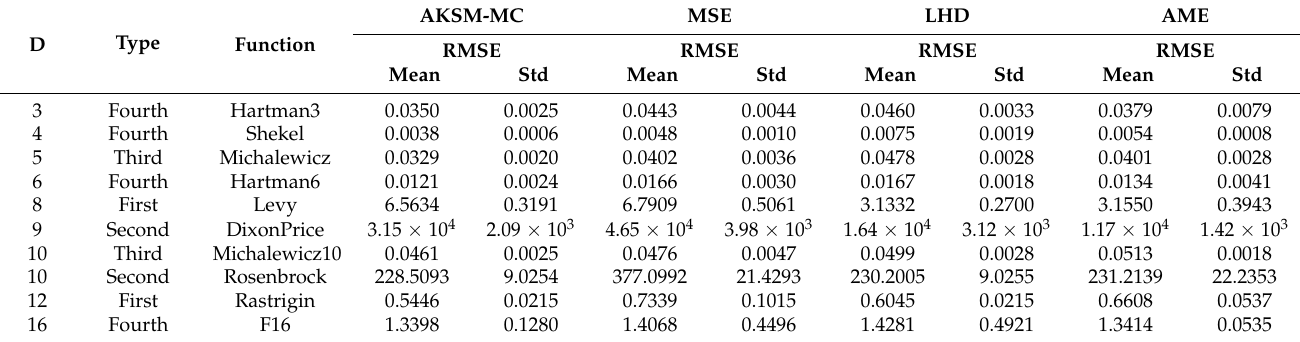
Table 5. RMSE results of HKM-HS, MMSE, LHD and AME algorithms tested on 10 benchmark